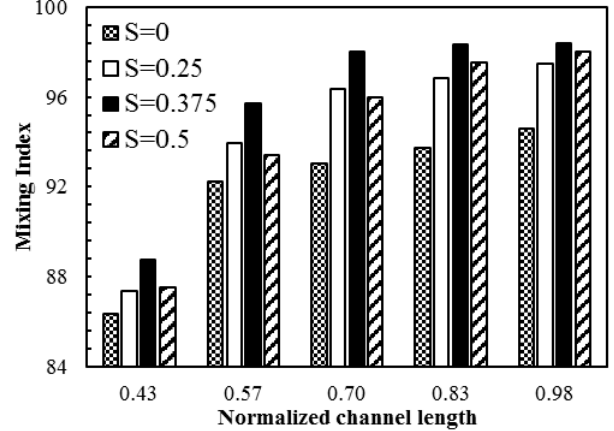
Figure 17. Comparison of the mixing index developments along the normalized channel length among the micromixers with different patch spaces at E = 400 V/cm.